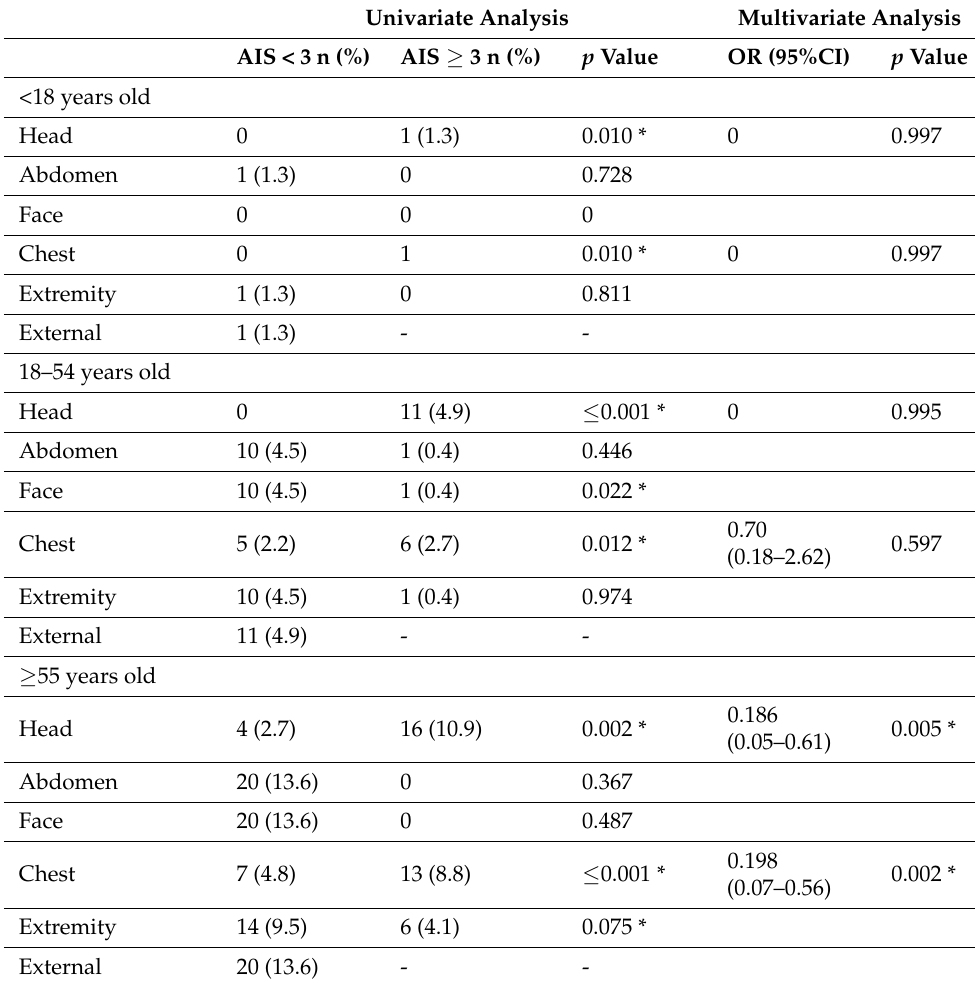
Table 2. AIS distribution in age